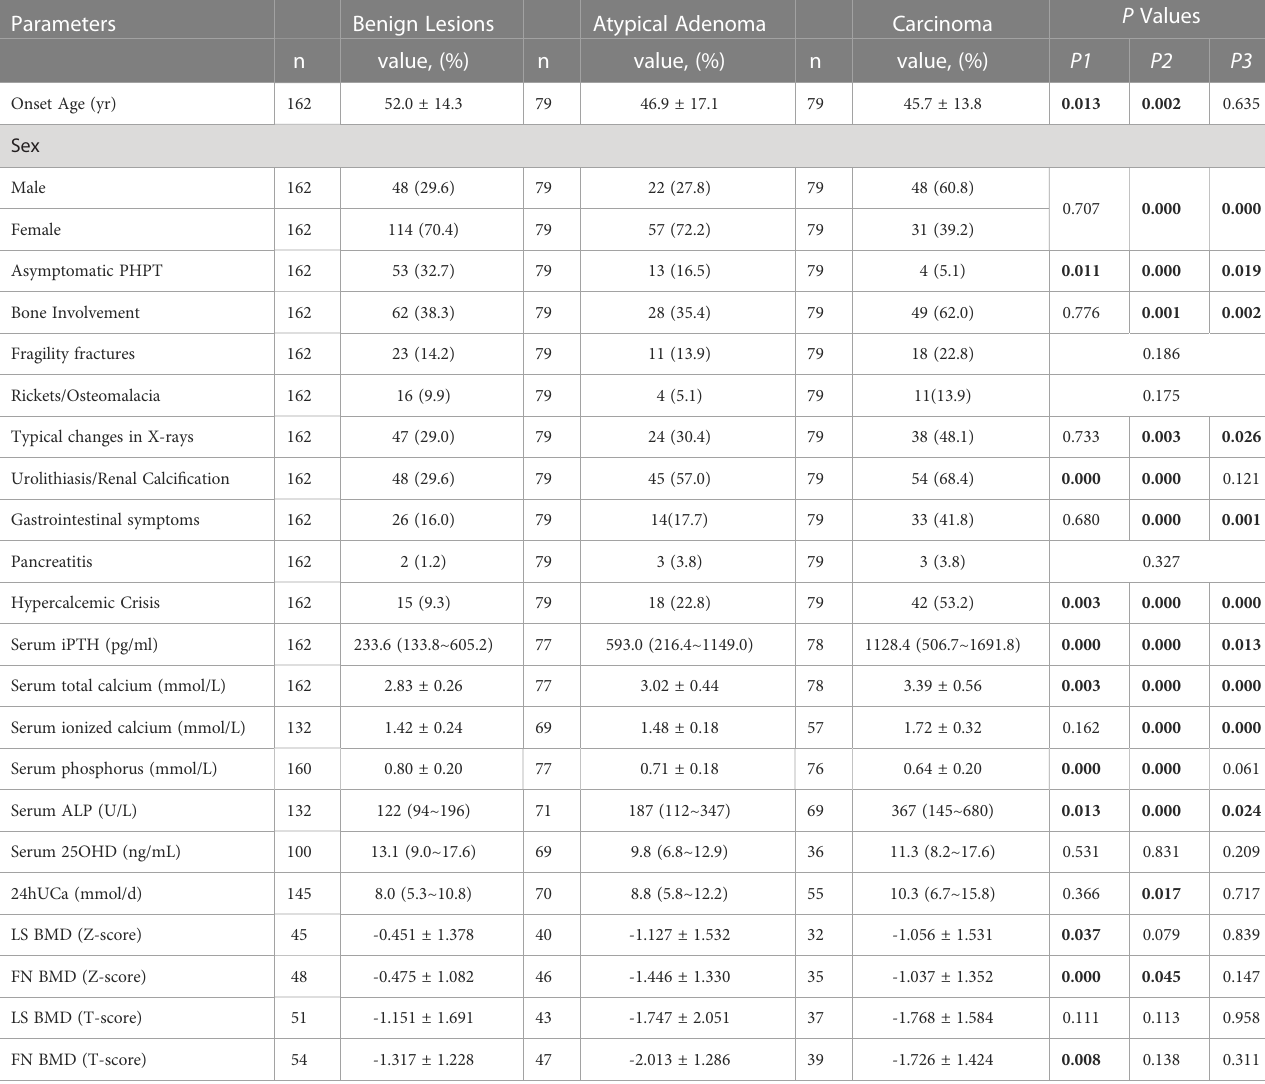
TABLE 1 Demographics, clinical presentation, biochemical and densitomatric parameters of patients with pathologically con fi rmed primary hyperparathyroidism.